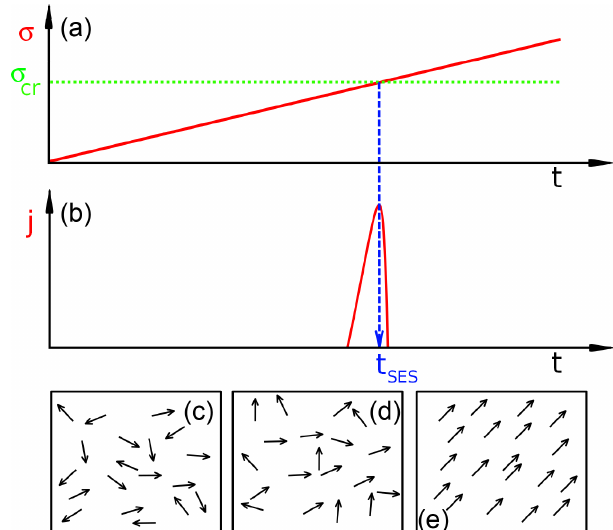
Figure 2. Schematic diagram of the physical model proposed for the SES generation. (a) Before an EQ, the stress σ gradually increases in the focal area versus the time t towards reaching a critical value σ cr . (b) When σ reaches σ cr a transient electric signal is emitted that constitutes an SES. (c) Random orientation of the electric dipoles at small stress. (d) Partial orientation at an intermediate stress σ(< σ cr ) . (e) Cooperative orientation of the electric dipoles when σ = σ cr